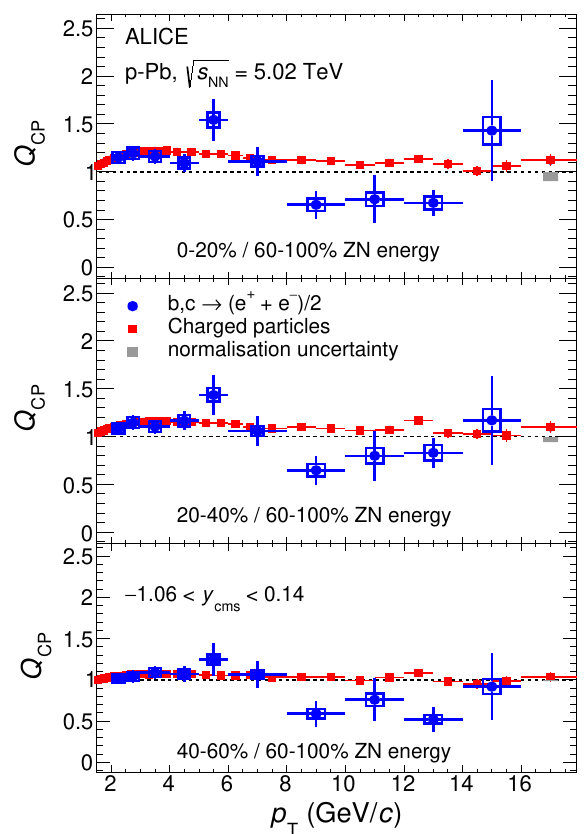
Figure 8 . Q cp of electrons from heavy-(cid:13)avour hadron decays in 0{20%, 20{40% and 40{60% p multiplicity classes in p-Pb collisions at s NN = 5 : 02 TeV. The vertical error bars and the empty boxes represent the statistical and systematic uncertainties, respectively. The solid boxes at high p T at Q cp = 1 represent the normalisation uncertainties. The results are compared to ALICE results p on charged particles in p-Pb collisions at s NN = 5 : 02 TeV [44].